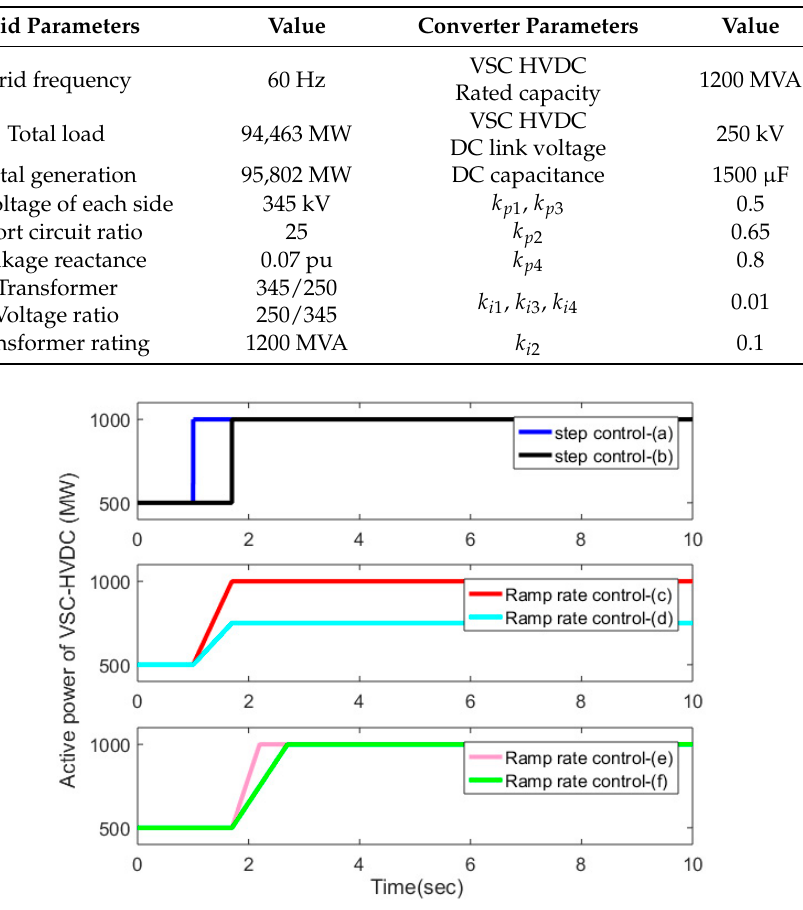
Figure 10. Six power control schemes of the VSC-HVDC.